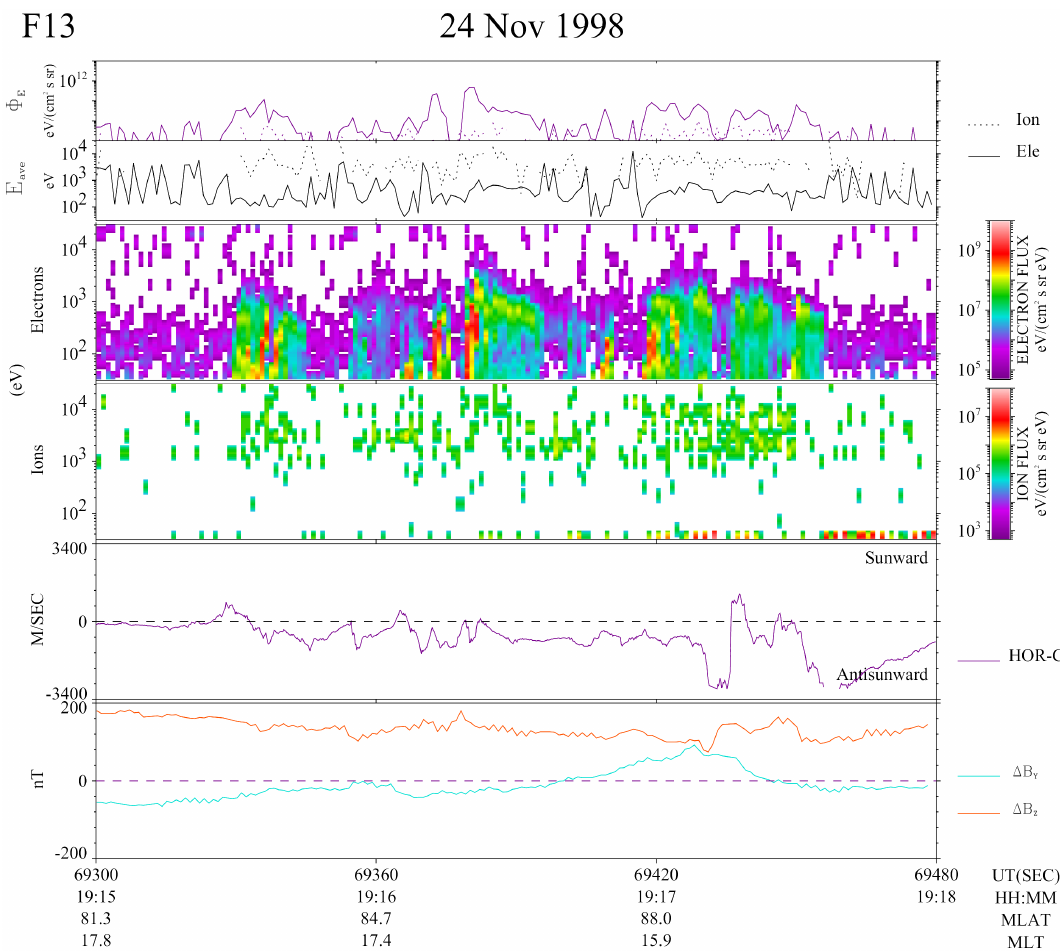
Fig. 4. Plot of a three minute interval from Fig. 3 which includes the high-latitude